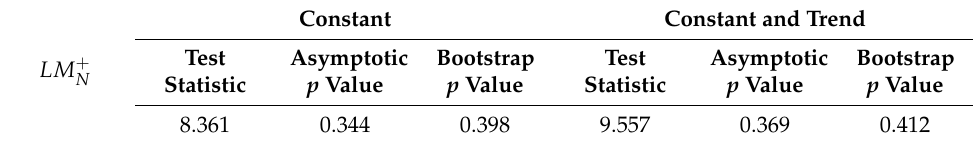
Table 6. Pesaran (2007) CIPS unit root test.